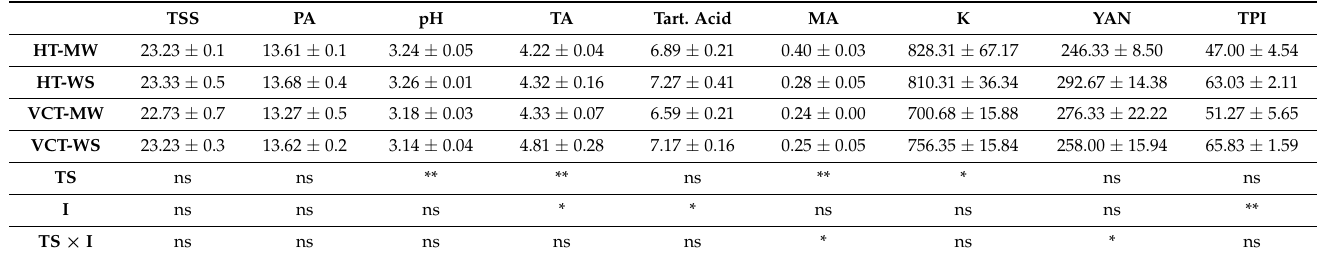
Table 5. Parameters of must composition at harvest for cv. Maturana Blanca grapes for each treatment. Abbreviations are as follows: TSS (total soluble solids, ◦ Brix), PA (probable alcohol % v / v ), TA (titratable acidity, g L − 1 of tartaric acid), Tart. acid (tartaric acid, g L − 1 ), MA (malic acid, g L − 1 ),